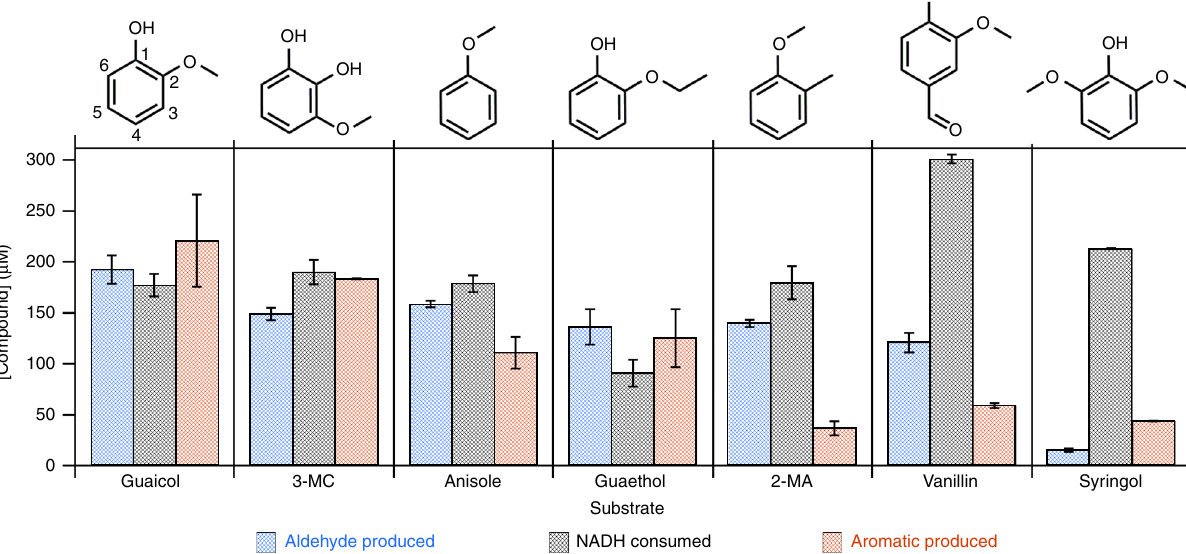
Fig. 4 GcoAB O -demethylates a range of lignin-derived substrates. A total of 300 µ M NADH and O -methyl-aryl compounds were incubated in air with 0.2 μ M GcoA and B (each) for 6.75 min prior to quenching the reaction with saturated ammonium sulfate and 7% v/v concentrated H 7.4, 25 °C). The products were then analyzed. The total NADH consumed is compared above to the amounts of aldehyde and de-alkylated aromatic compound produced. Error bars represent ±1 standard deviation from three or more independent